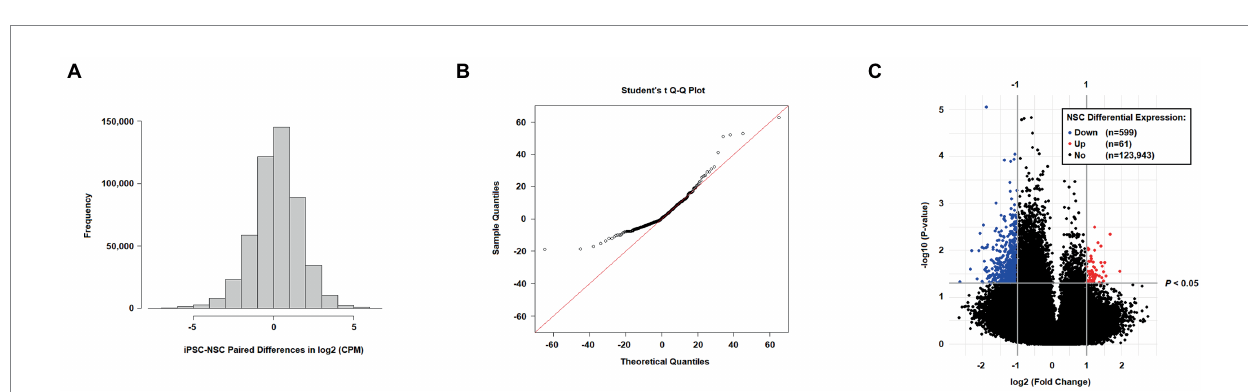
FIGURE 2 (A) Distribution of iPSC-NSC paired differences in log base 2 counts per million (CPM; VOOM transformation); (B) Student’s t quantile-quantile (Q-Q) plot for results from t -tests comparing VOOM-adjusted 5hmC counts between iPSC and NSC cell lines; and (C) Volcano plot of differential 5hmC expression (log base 2 FC; log base 10 t -test p values) among filtered sites for NSC cell lines relative to iPSC expression levels (downregulation defined as FC < − 1 and p < 0.05; upregulation defined as FC > 1 and p <